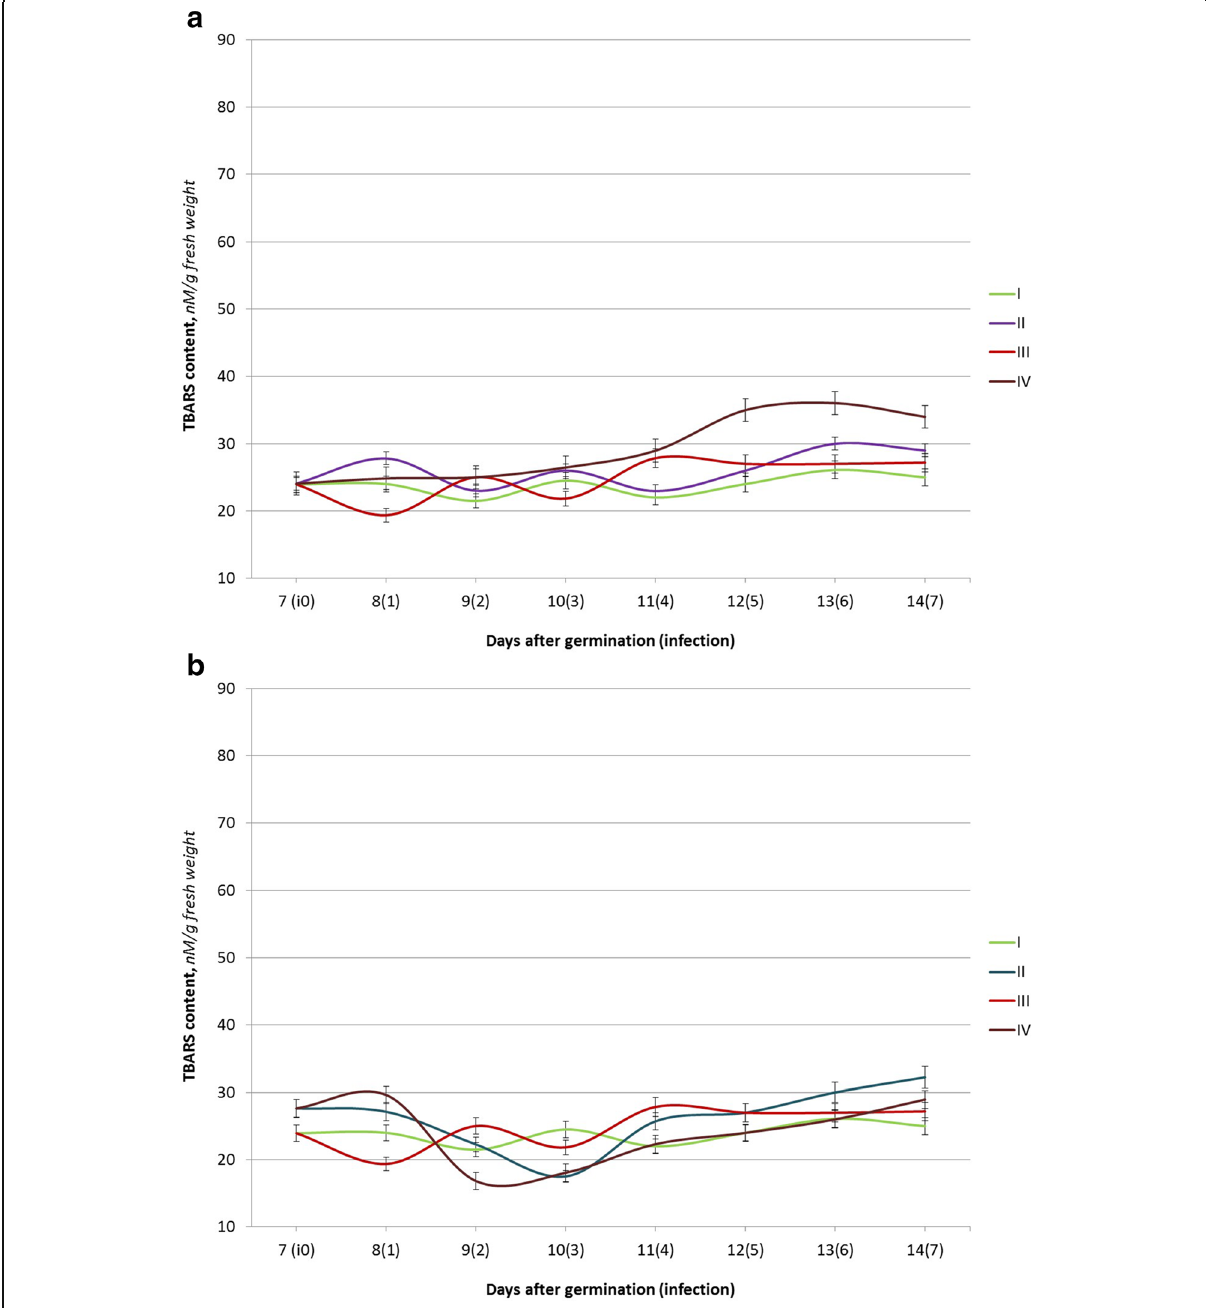
Fig. 2 The TBARS content of seedlings of winter wheat (the Roazon variety) under the action of Ag ( a ) or Cu ( b ) nanoparticle solutions and P. herpotrichoides infection: I control plants (w/o infection); II seed treatments with Ag ( a ) or Cu ( b ) nanoparticle solutions; III P. herpotrichoides infections; IV P. herpotrichoides infections + treatments with Ag ( a ) or Cu ( b ) nanoparticle